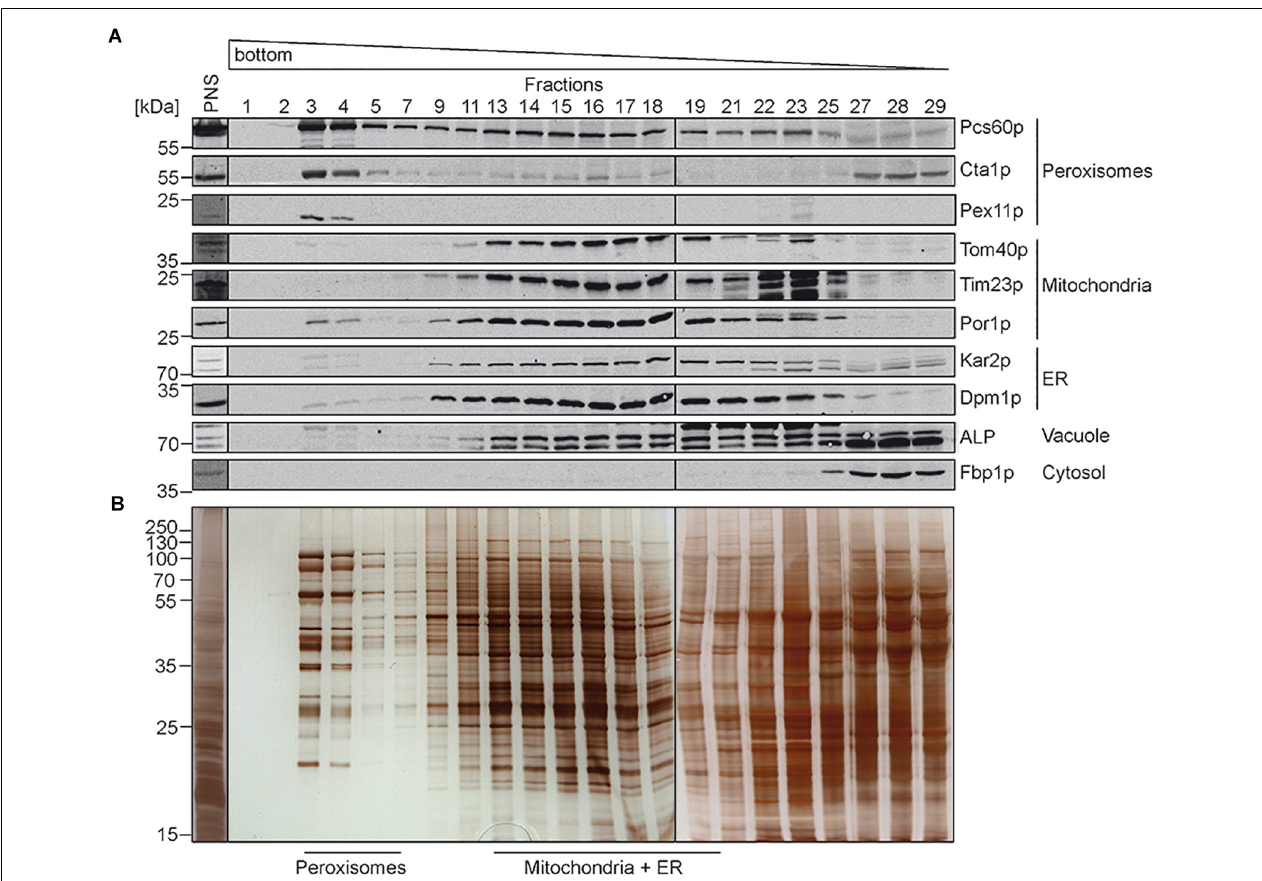
FIGURE 1 | Isolation of peroxisomes by isopycnic density gradient centrifugation. Cells of S. cerevisiae wild-type strain were grown under oleate-inducing conditions for 16 h. A post nuclear supernatant (PNS) was prepared, and organelles were separated on an OptiPrep TM /sucrose gradient. Fractions were collected from the bottom of the gradient. Equal volumes of the indicated gradient fractions were separated by SDS-PAGE and analyzed by (A) immunoblotting using antibodies against Pcs60p (peroxisomal matrix protein), Cta1p (catalase; peroxisomal matrix protein), Pex11p (peroxisomal membrane protein), Tom40p and Por1p (mitochondrial outer membrane protein), Tim23p (mitochondrial inner membrane protein), Kar2p (ER luminal protein), Dpm1p (ER membrane protein), ALP (vacuole), and Fbp1p (cytosol), or by (B) silver staining. Peroxisome-containing fractions (3–5) were pooled, enriched and used for fluidity and lipidomic analysis. Fractions of mitochondria and ER containing membranes (13–19) were processed for further purification ( Figure 2 ).